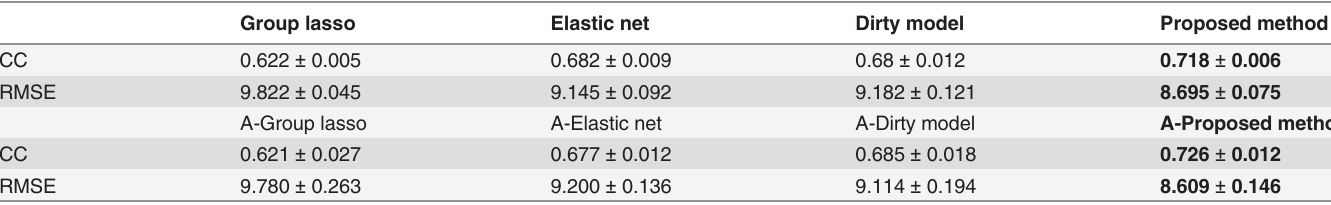
Table 2. Performance (mean ± standard deviation) comparison among all competing methods in both